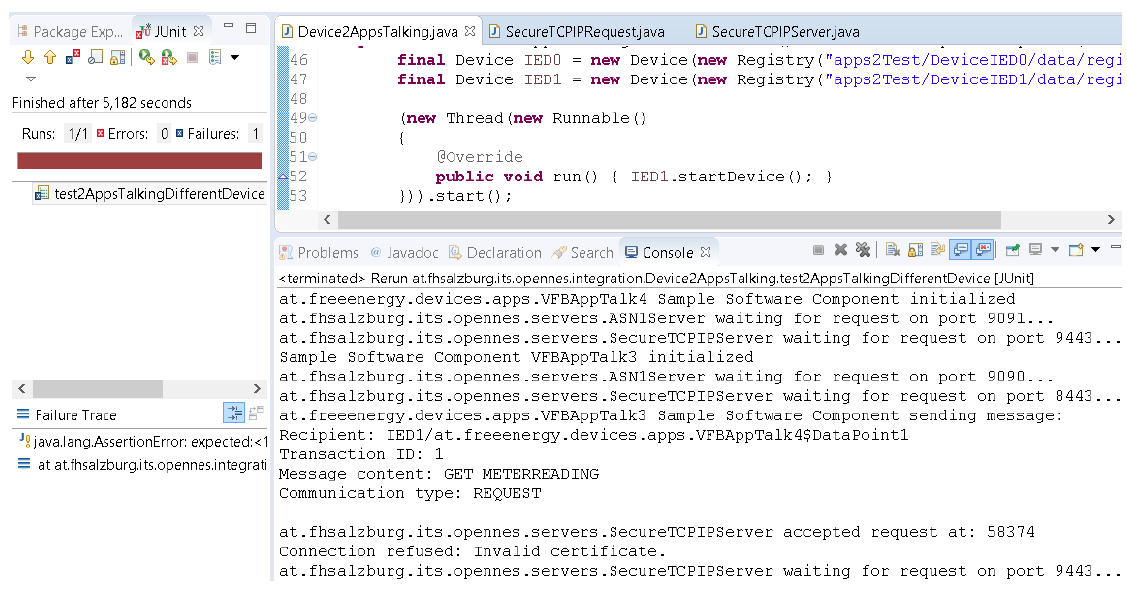
Figure 20. Refused request due to invalid